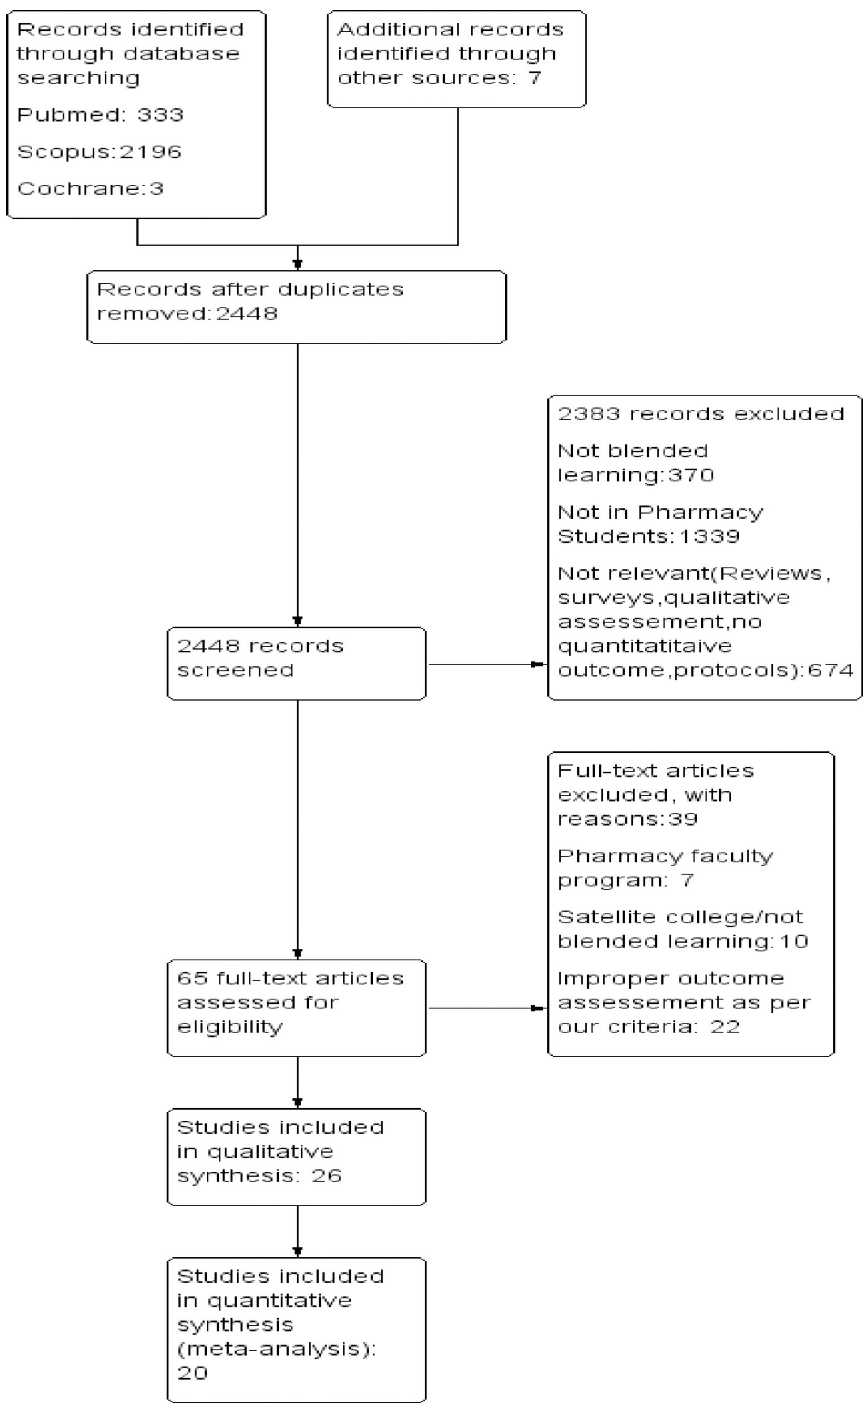
Fig 1. PRISMA flow